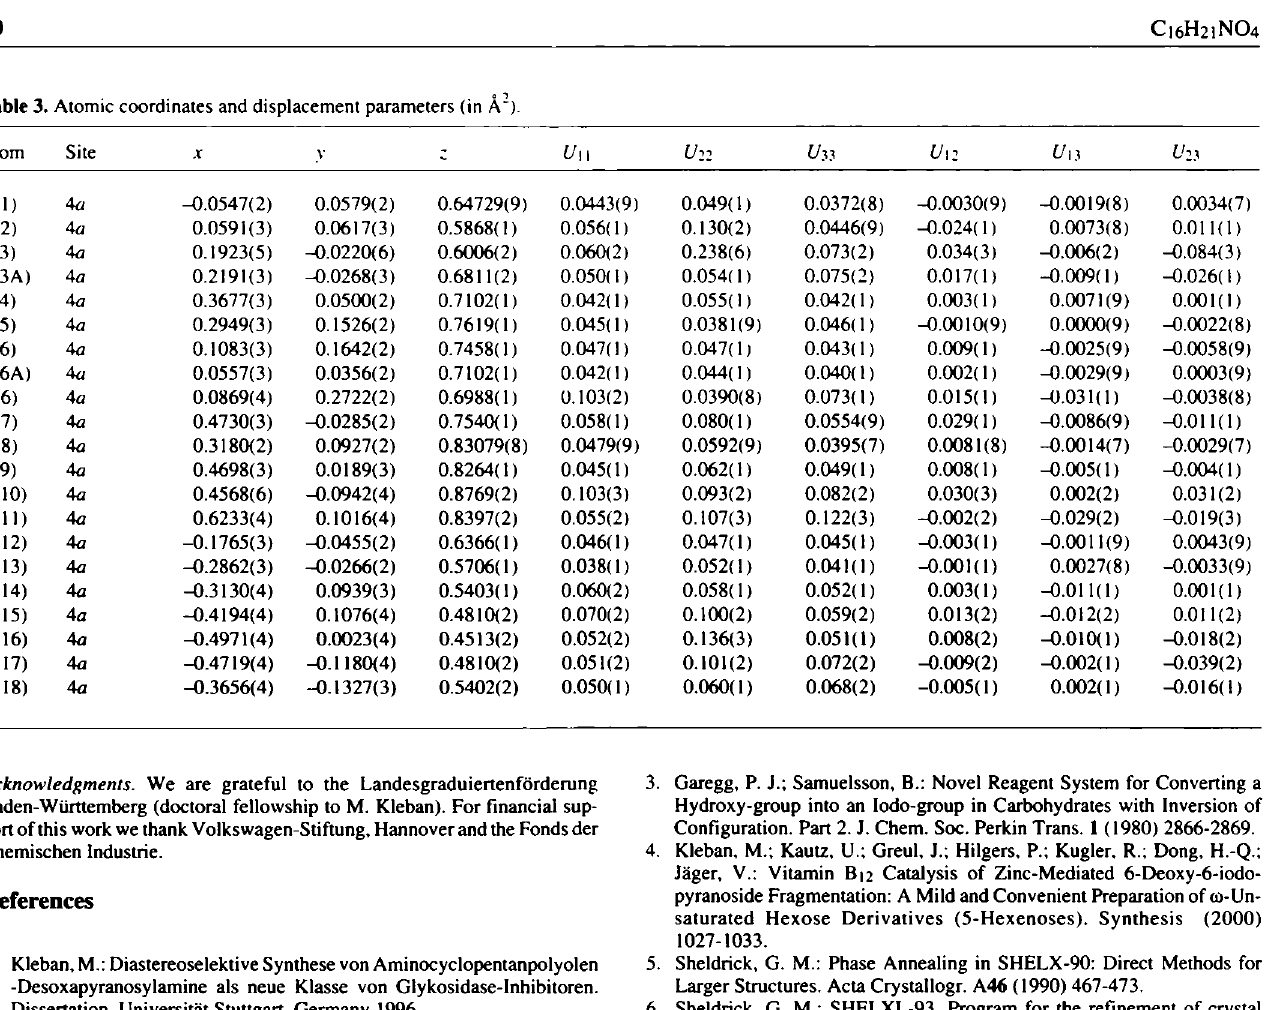
Table 3. Atomic coordinates and displacement parameters (in A 2